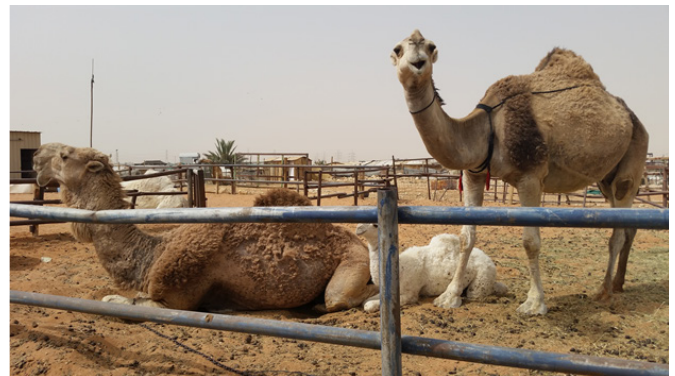
Figure 2. Photo from camel market outside Riyadh, Saudi Arabia where MERS-CoV(Middle East respiratory syndrome- Coronavirus) was first detected. Dromedary (one-hump) camels are strongly linked to having a role as a MERS-CoV reservoir and source of zoonotic transmission to